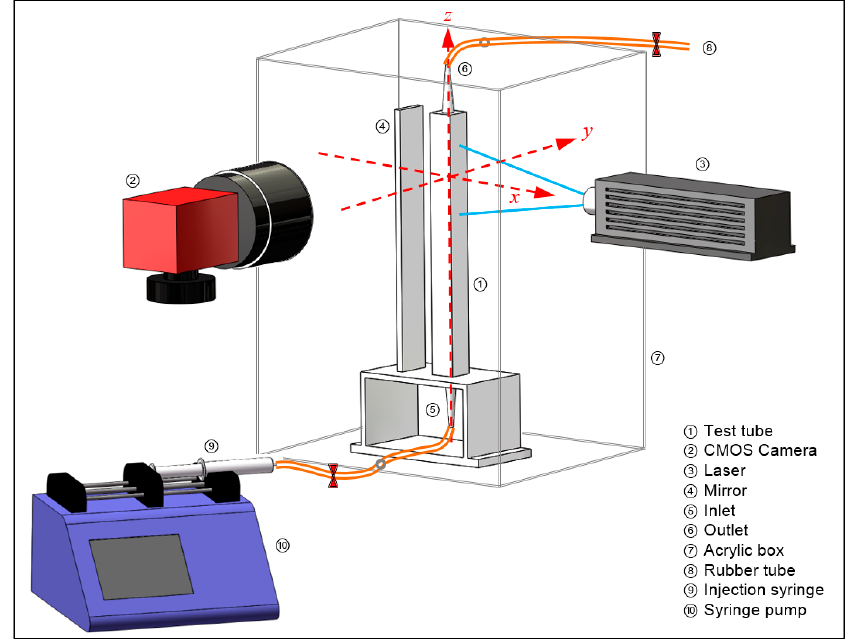
Figure 1. Experimental setup.